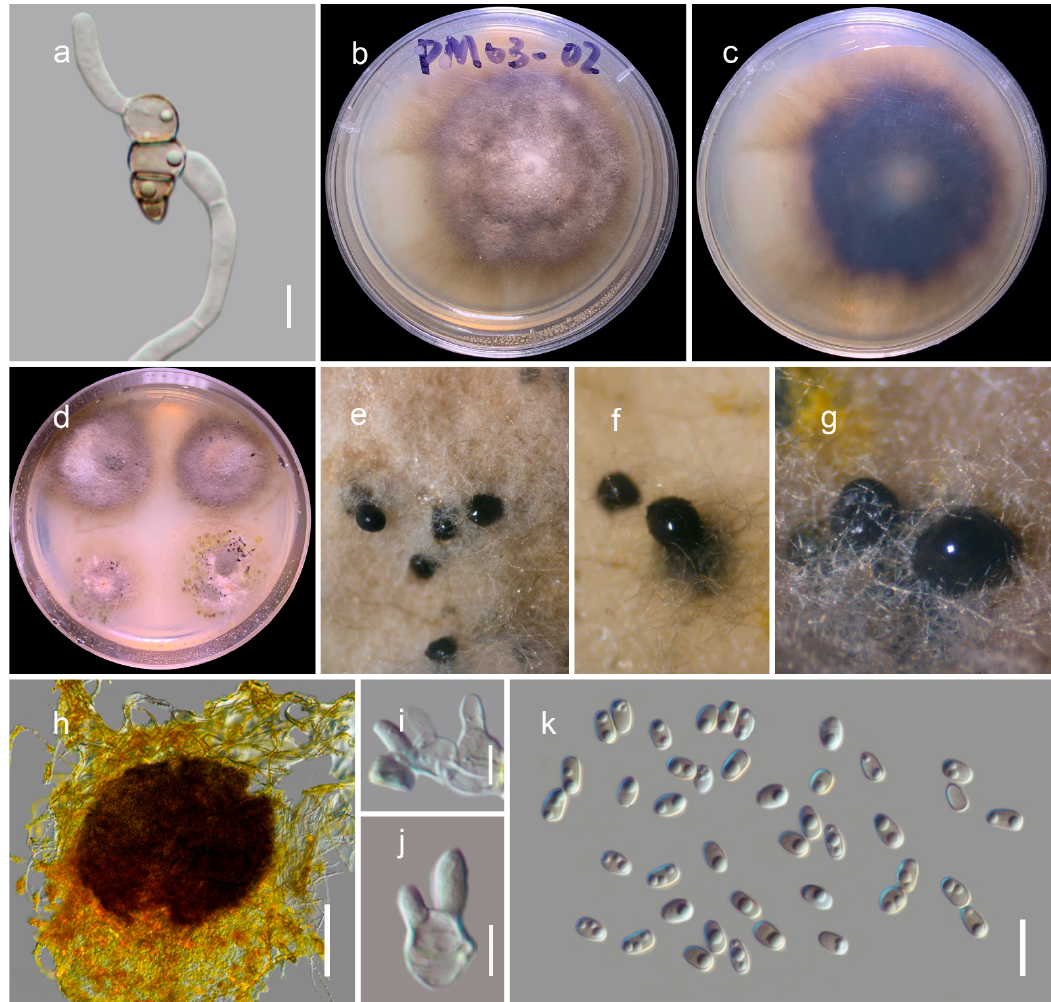
Figure 5. Sexual morph of Thyridaria jonahhulmei (HKAS122912, holotype). ( a,b ) Ascomata on the dead woody twigs; ( c,d ) cross section of ascomata; ( e ) close-up of ostiole; ( f ) peridium; ( g ) pseudo- paraphyses; ( h – j ) asci; ( k – p ) ascospores. Scale bars, ( d ) 200 μ m; ( e ) 50 μ m; ( f,h – j ) 20 μ m; ( f , k – p ) 10 μ m.